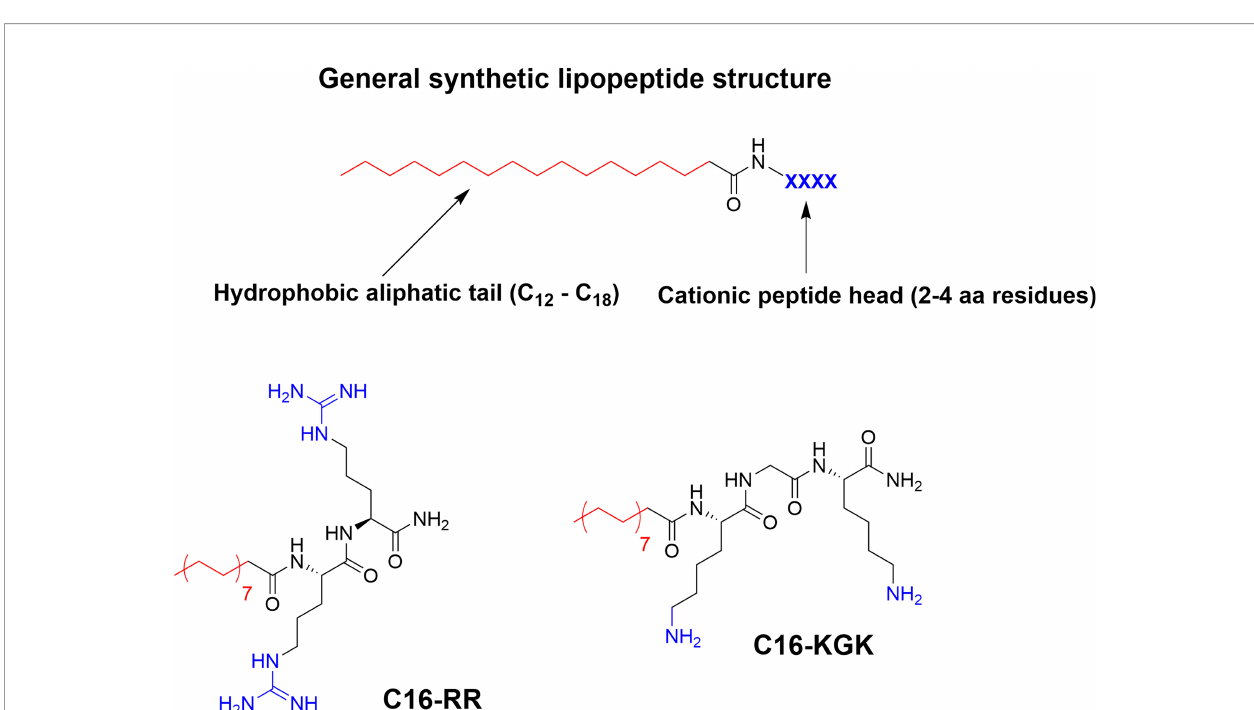
FIGURE 7 | General structure of a USLiP and bioactive examples with a cationic di- to tripeptide providing the cationic charge to suf fi ciently balance the N-terminal fatty acid tail to generate potent antimicrobial amphiphiles (100, 102).